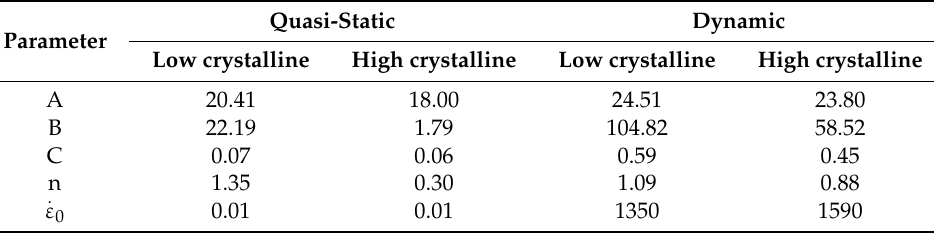
Table 2. Johnson-Cook parameters derived from compression experiments for low crystalline and high crystalline